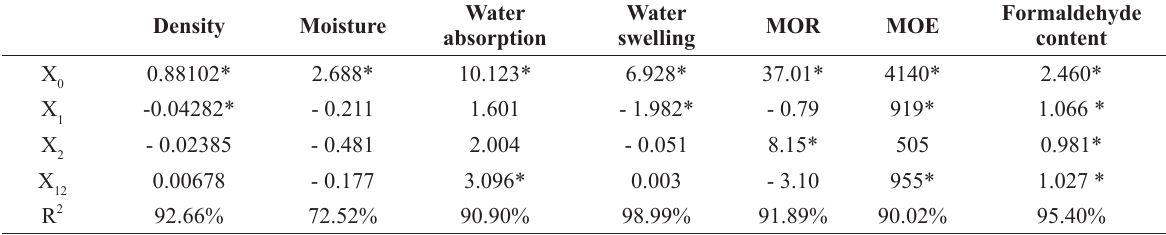
ANOVA analysis from response